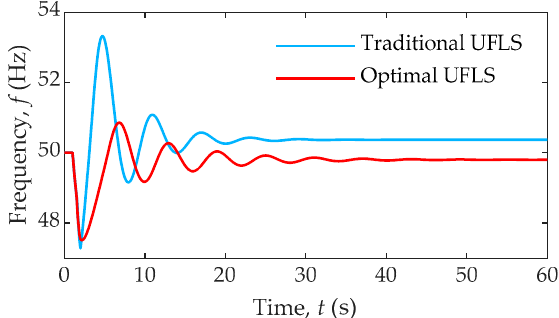
Figure 7. Frequency response in AURPS after disconnection of the Murun-Telmen 110 kV transmission line for high inertia—summer season scenario.